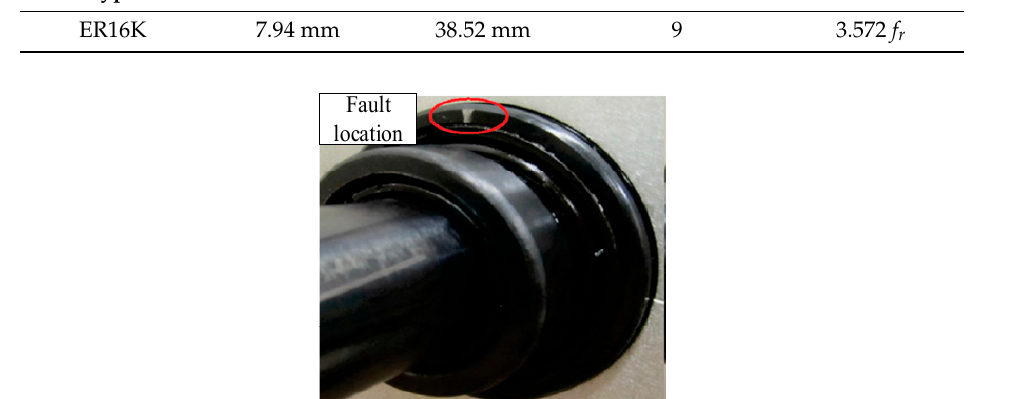
Figure 9. The fault bearing used in the experiment.